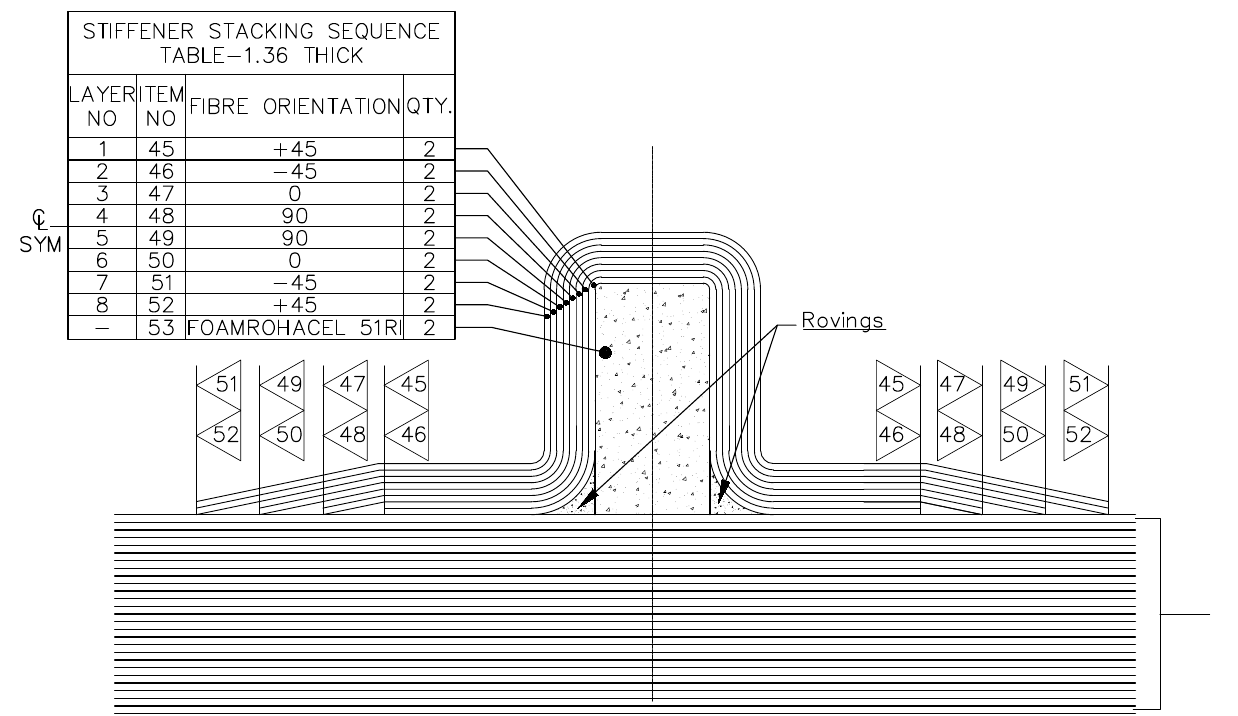
Figure 6. Layup sequence for